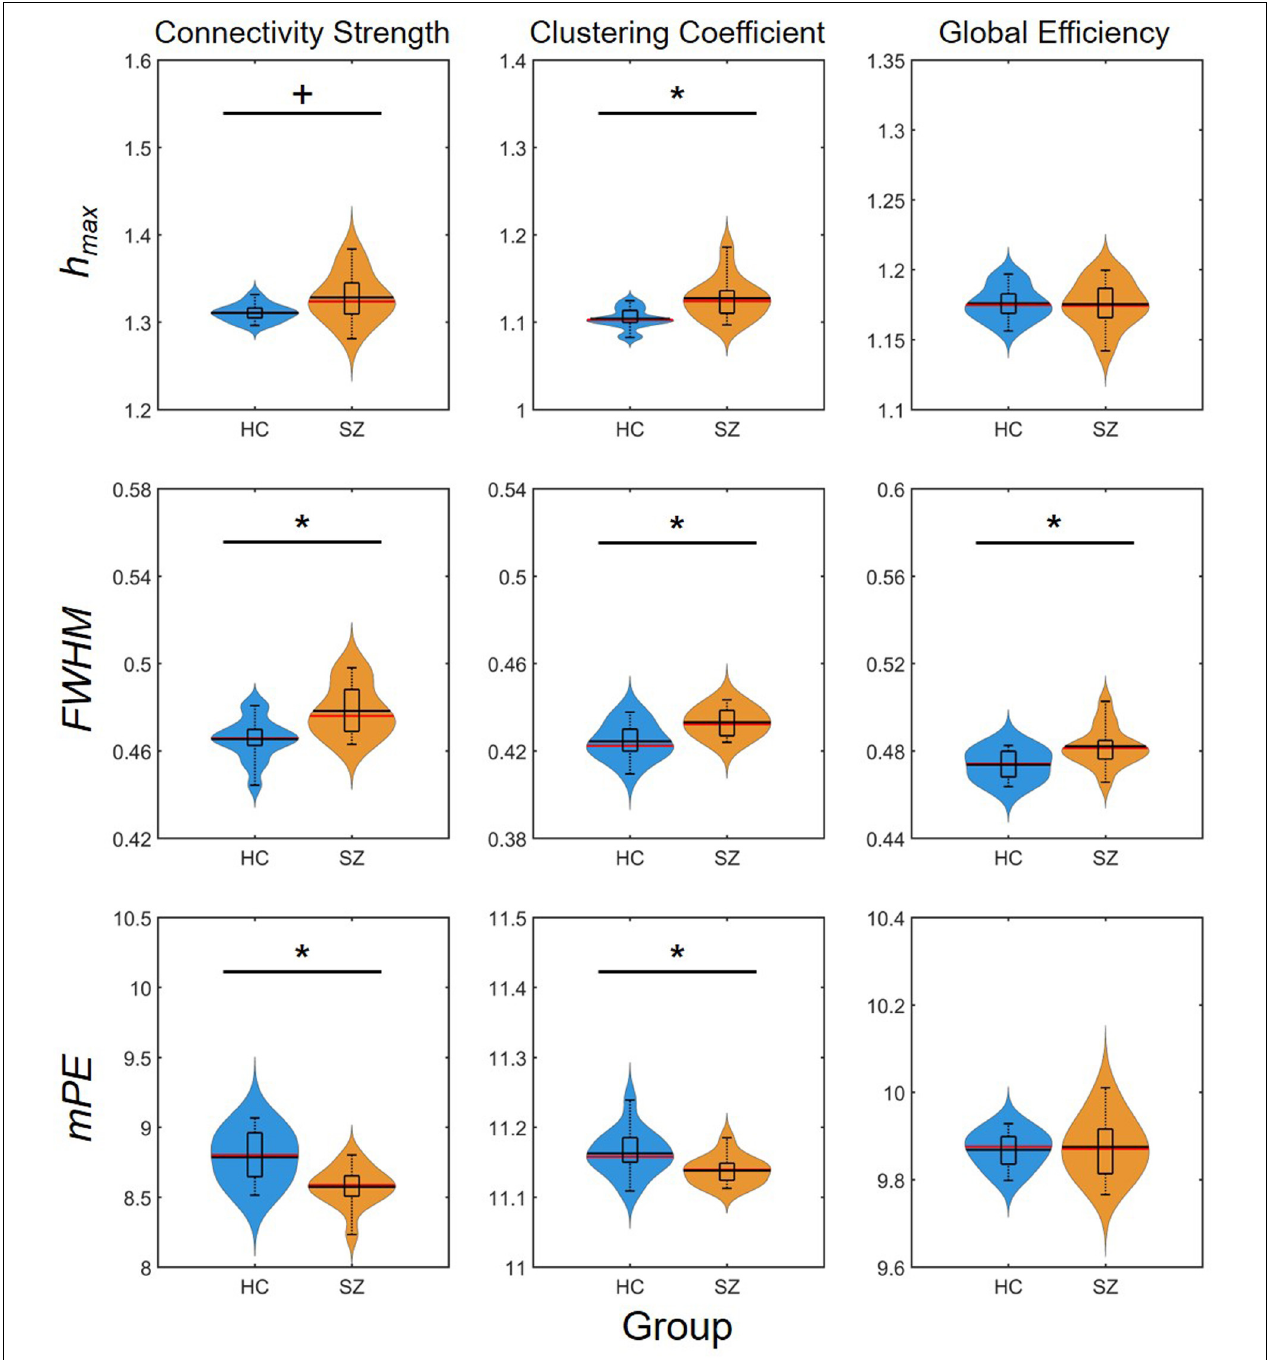
FIGURE 7 | Results of the area-under-the-curve analysis regarding multifractal and entropy-related properties of dynamic network measures. Black markers indicate significant group level difference ( p < 0.05). * Two-sample t -test; + Mann–Whitney U -test; HC, healthy control; SZ, schizophrenia; h max , Hölder exponent at the peak of the multifractal spectrum; FWHM , full width at half maximum; mPE , modified permutation